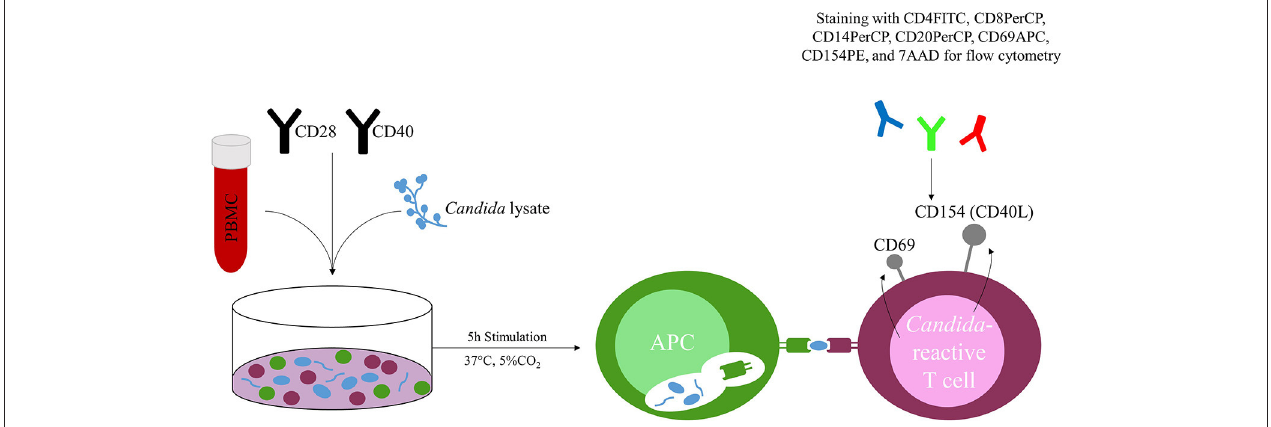
FIGURE 1 | Concept of the Candida -reactive lymphocyte assay. Peripheral blood mononuclear cells (PBMC) are co-incubated with Candida spp. specific lysate (e.g., C. albicans ) and stimulated with CD28 and CD40 antibodies. T cells react to the presented fungal peptides on the surface of antigen presenting cells (APC) and upregulate the activation markers CD69 and CD154 (CD40L), which are quantified by flow cytometry after 5h stimulation at 37 ◦ C and 5% CO 2 .